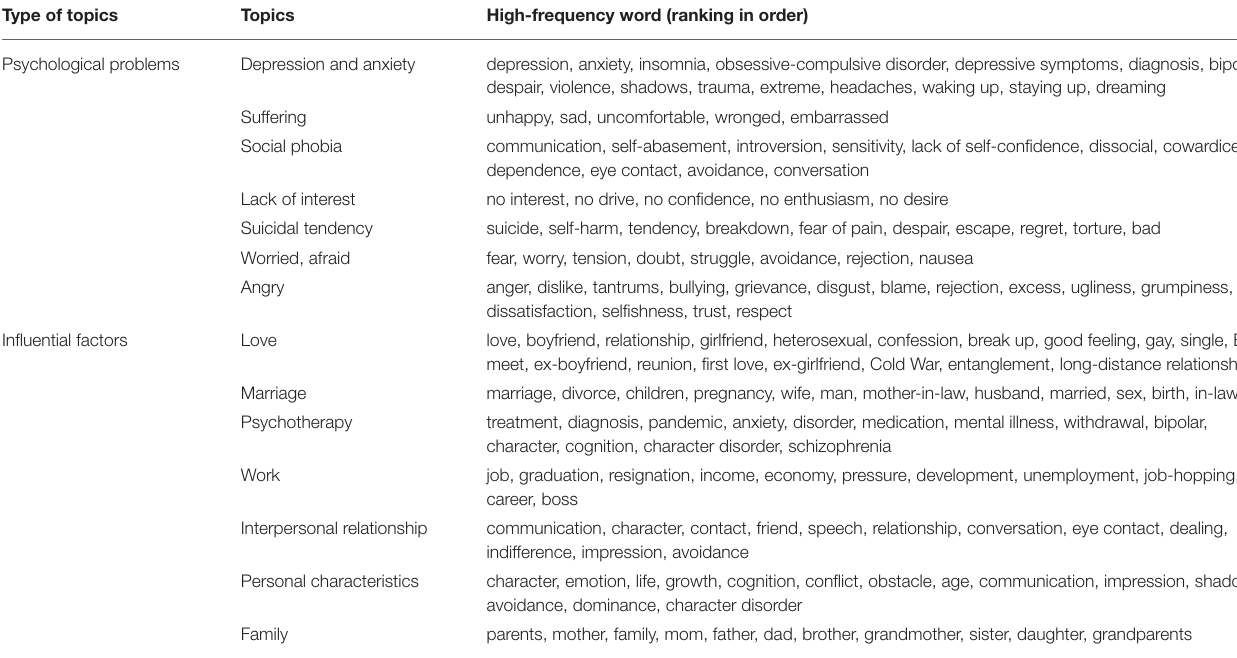
TABLE 2 | The mental health topics related to the OPHS behavior. Type of topics